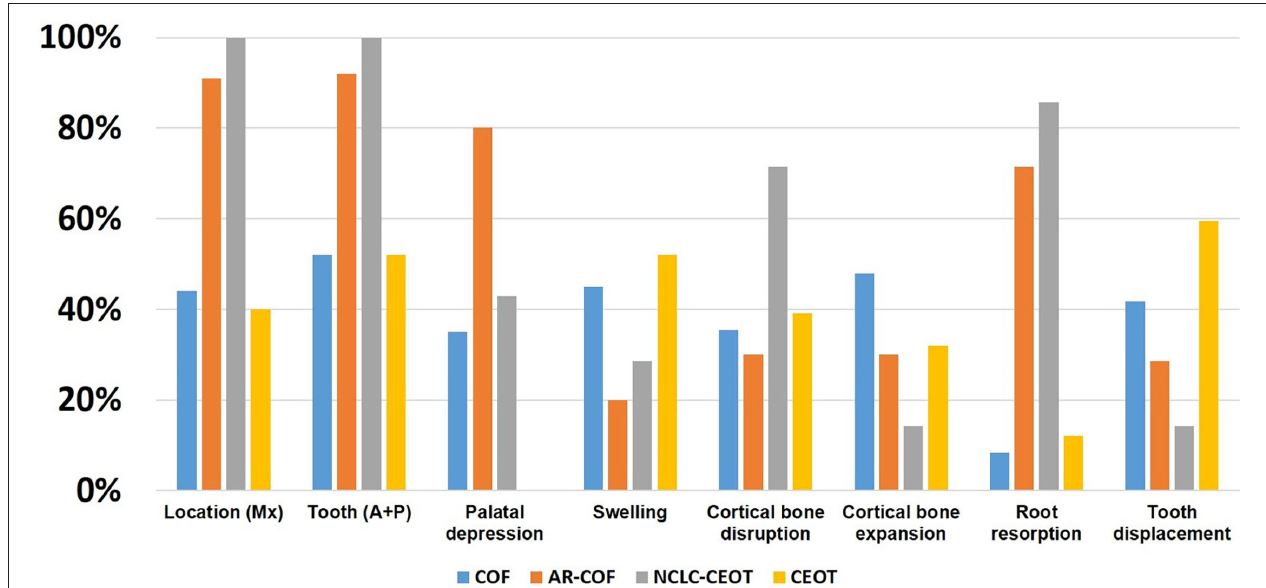
FIGURE 5 | Comparison of the distribution of clinical findings in the COF, AR-COF, NCLC-CEOT, and CEOT cases.